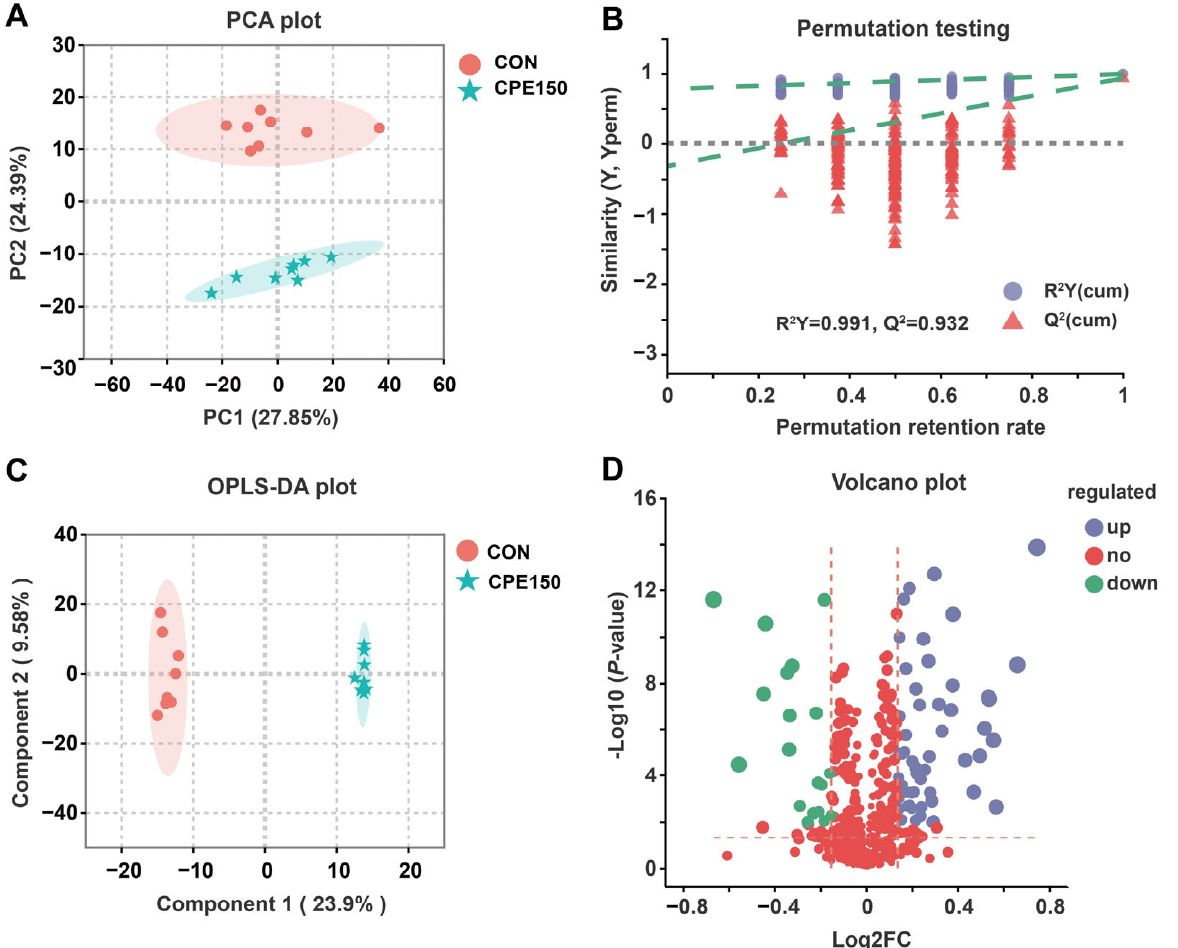
Figure 4. Milk metabolome analysis of dairy cows fed the control diet, and supplementary citrus peel extracts at 150 g/d (CPE150). ( A ) Unsupervised PCA of milk metabolites. ( B ) Permutation testing of the supervised orthogonal partial least squares-discriminate analysis (OPLS-DA) model; Q 2 , predictive ability parameter; R 2 Y, goodness-of-fit parameter. ( C ) OPLS-DA scatter plot. ( D ) Volcano plot of differential metabolites; Blue dots (‘up’) and green dots (‘down’) indicate up-regulated and down-regulated metabolites (CPE150 vs. CON), respectively; red dots (‘no’) indicate metabolites for which there was no significant difference (CPE150 vs. CON); FC, fold change.